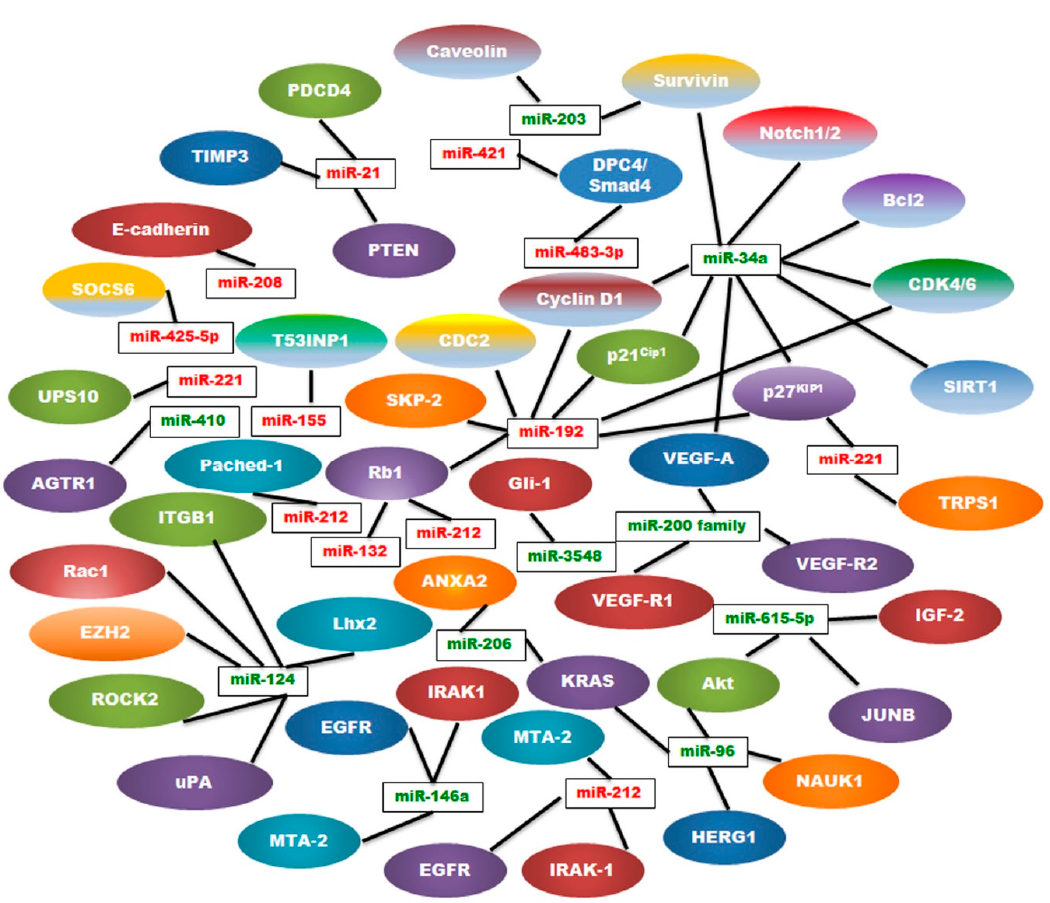
Figure 3. Gene regulatory network of several miRNAs (oncomiRs in red and TSmiRs in green) and their targets in pancreatic cancer.